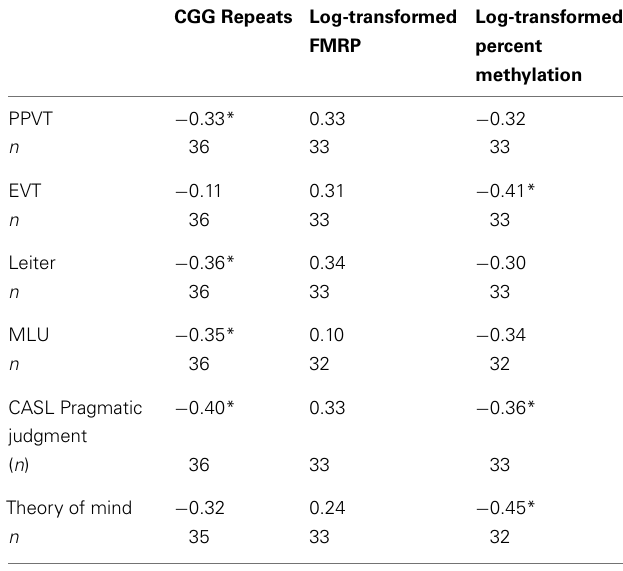
Table 4 | Genetic correlations with language (structural and pragmatic language), general cognition, and theory of mind in the FXS